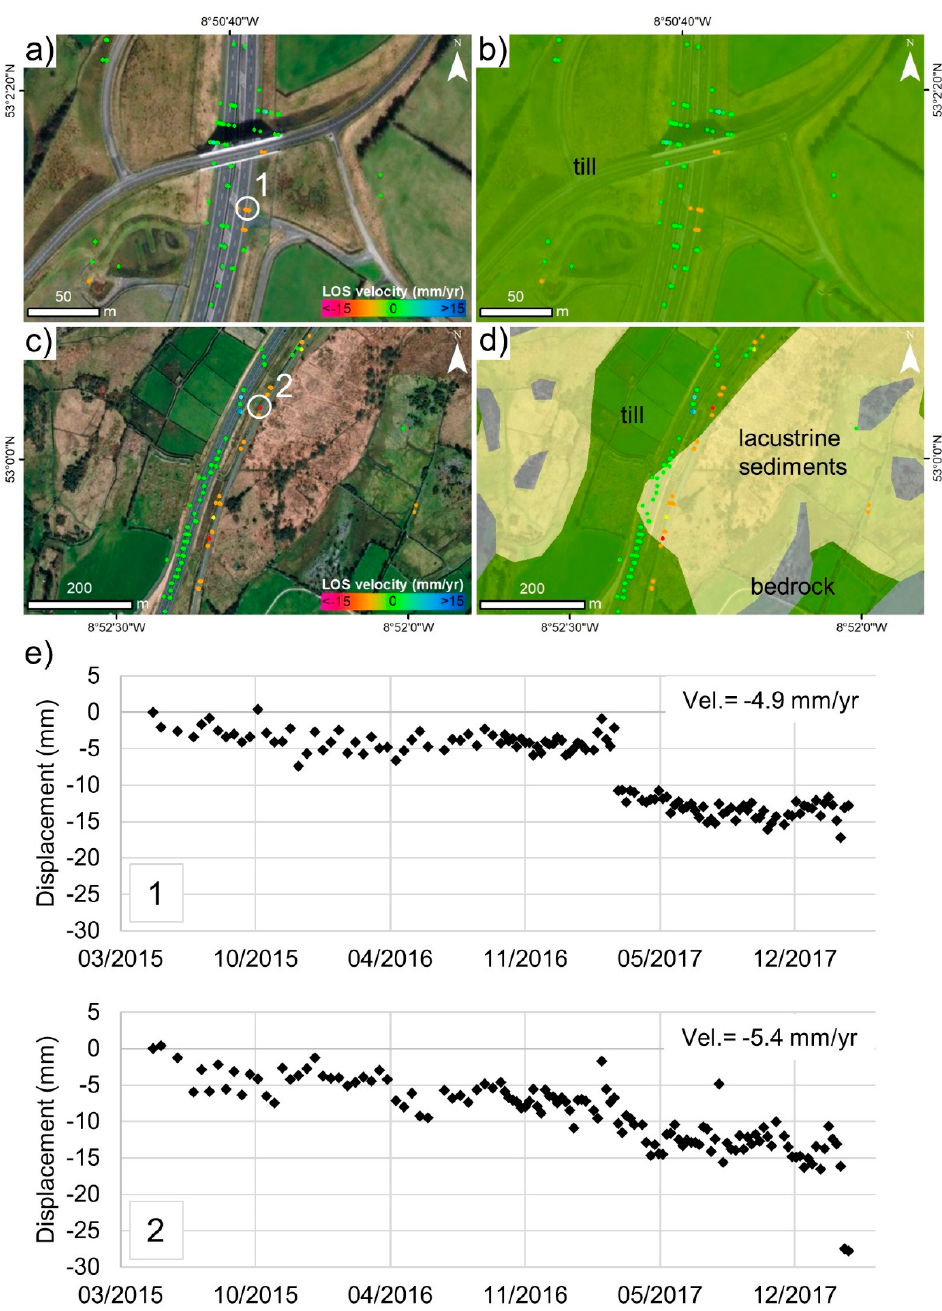
Figure 12. Examples of ground instabilities affecting motorway and railway infrastructure in AOI-1: ( a ) M18 motorway south of Gort, denoted locality ‘d’ in Figure 7; ( c ) railway on the Galway-Limerick line, denoted locality ‘e’ in Figure 7. Maps of Pleistocene-Holocene superficial deposits and bedrock outcrop for each area are presented in ( b ) and ( d ); the colors correspond to the legend in Figure 4b. ( e ) Displacement time series of the points selected (white circles) for the motorway ( 1 ) and the railway ( 2 ).